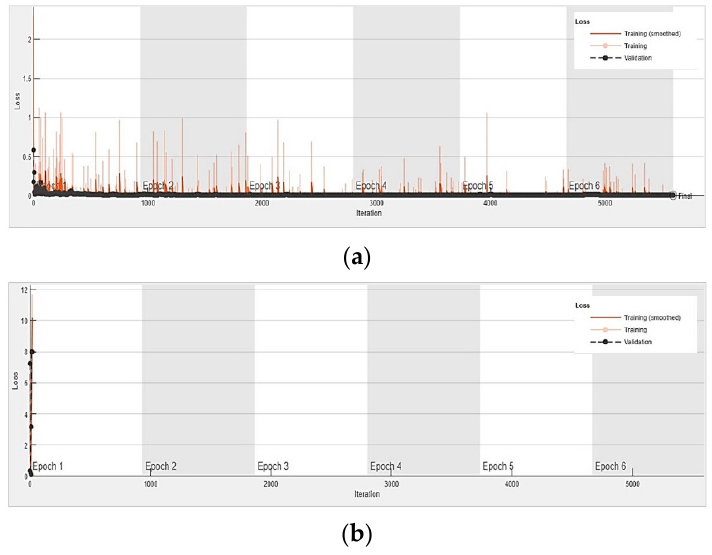
Figure 4. Training progress plot of loss (%) with different learning rates: (a) 0.0001; (b) 0.001.